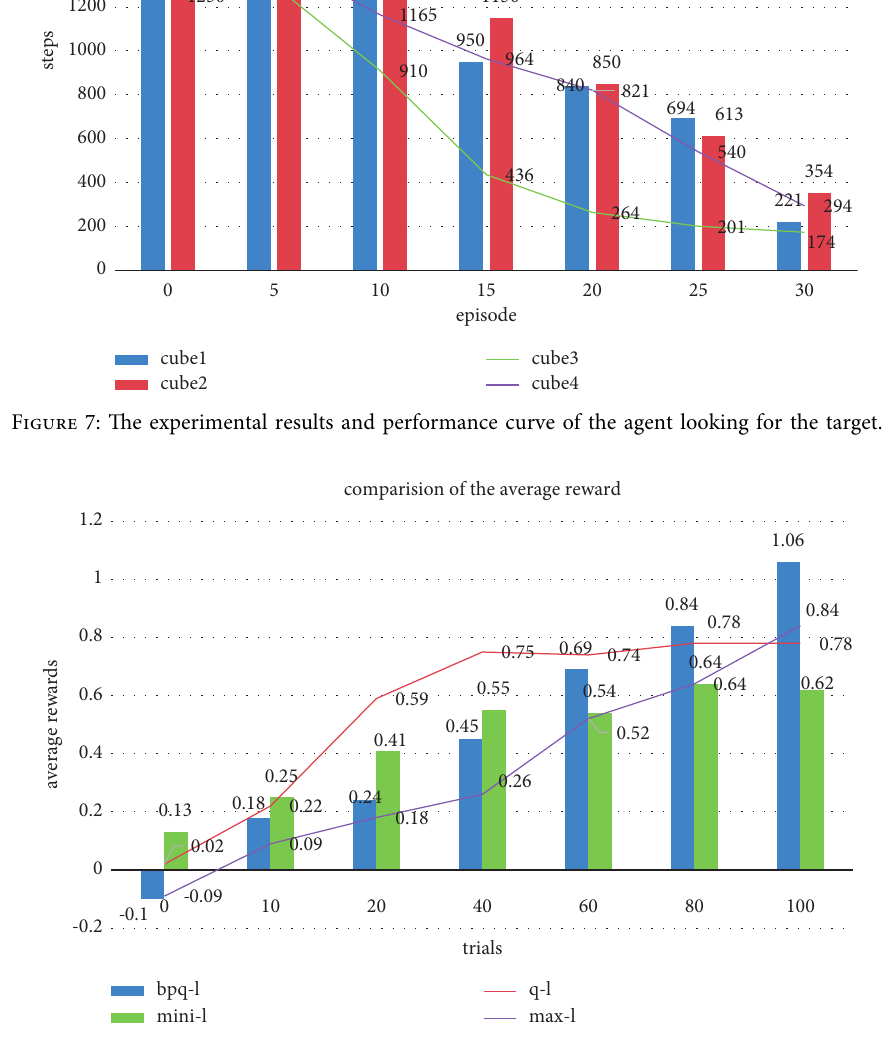
Figure 8: Comparison of the average reward value of improved Q learning and traditional Q